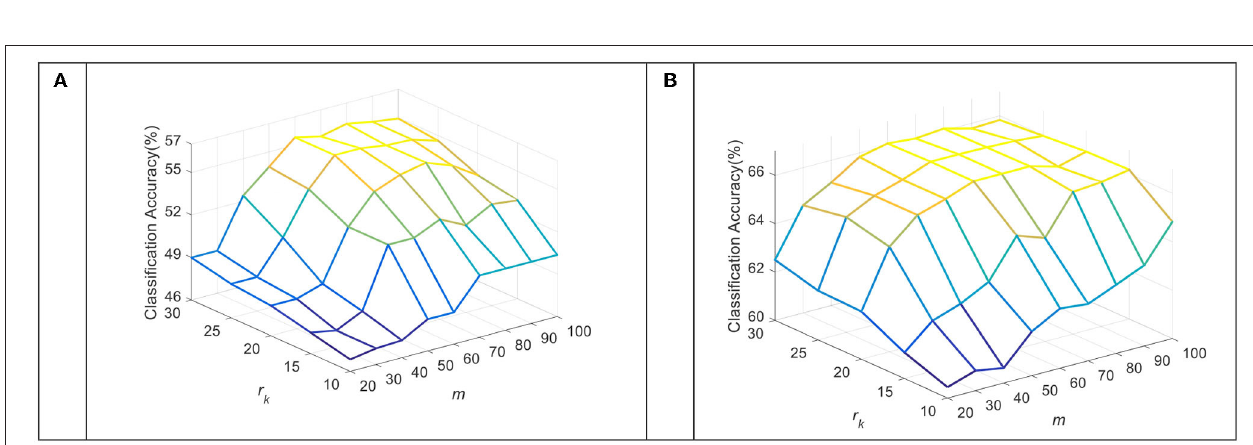
FIGURE 5 | The average classification accuracy of the TDDPL approach under varying m and r k on the SEED dataset. (A) o → o scenario, (B) m → o scenario.